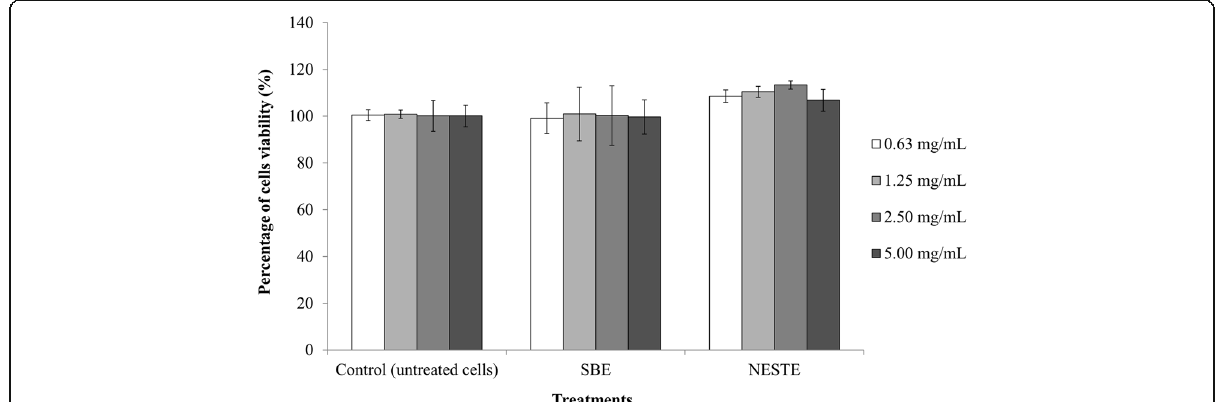
Fig. 1 Percentage of RAW264.7 cells viability by MTT assay after treated with various concentration of NESTE and SBE for 24 h. Note: All of the values are expressed as means ± S.E.M. from three separate